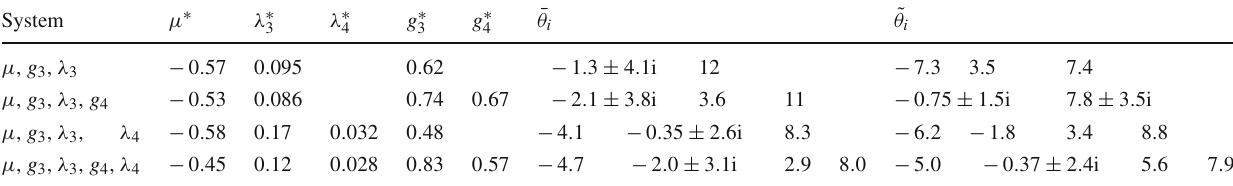
Table 1 Properties ofthe non-trivial UVfixed point for different orders of the vertex expansion scheme, computed for momentum dependent ( p 2 ) and bilocally projected Newton’s cou- anomalous dimensions η φ i plings g n ( k 2 ) . The critical exponents ¯ θ i and ˜ θ i stem from two